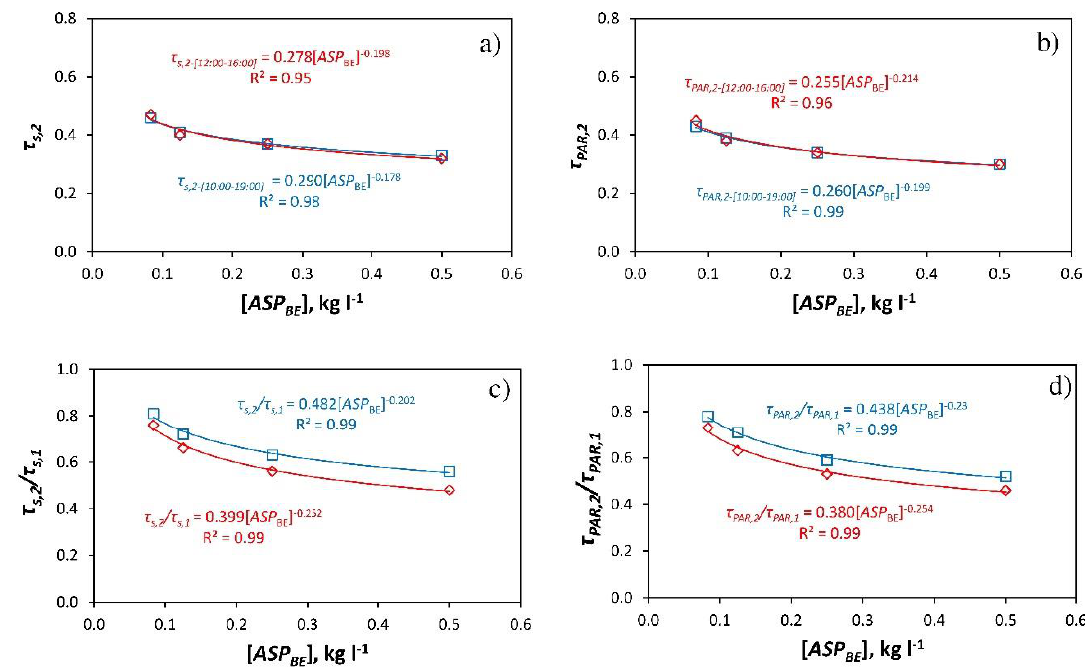
Figure 3. Mean values of transmissivity of the greenhouse cover for different concentrations of ASP BE . [ ASP BE ]; τ s , transmissivity to solar radiation ( a ); τ PAR , transmissivity to PAR ( b ). Mean values of the ratio τ s,2 / τ s,1 ( c ) y τ PAR,2 / τ PAR,1 ( d ). Subscript: 1 , sector 1 (without ASP BE ); 2 , sector 2 (with ASP BE ). □, 10:00 to 19:00; ◊, 12:00 to 16:00. Table 2. Mean values of transmissivity of the greenhouse cover in sector 1 (without ASP BE ) and sector 2 (with ASP BE ) for the experiments carried out in summer. DOY , day of year at the beginning of the test; [ ASP BE ], concentration in kg L − 1 ; τ s , transmissivity to solar/global radiation; τ PAR , transmissivity to PAR; R s , incoming solar radiation above the crop; R PAR , PAR radiation; Rn , net radiation. Subscript: 1 , inside sector 1 (without ASP BE ); 2 , inside sector 2 (with ASP BE ); o , outside. DOY [ ASP BE ]